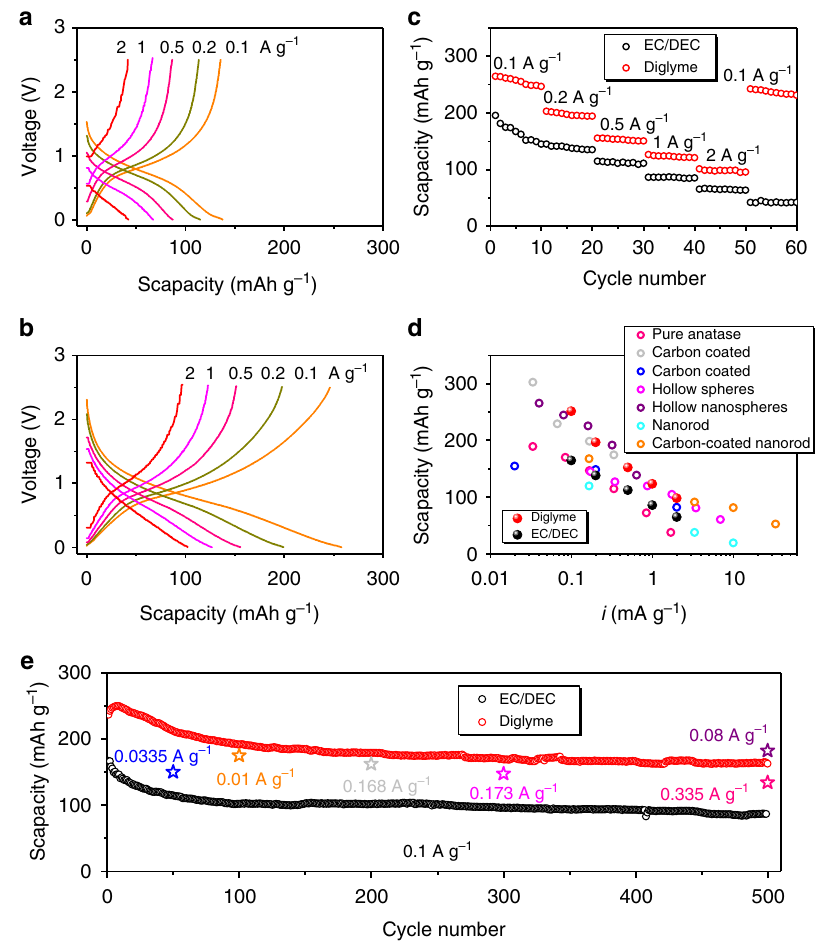
Fig. 1 Battery performance. a Voltage pro fi les of the TiO 2 anode at different rates using the EC/DEC-based electrolyte (scapacity: speci fi c capacity). b Voltage pro fi les of the TiO 2 anode at different rates using the diglyme-based electrolyte. Note that the pro fi les at 0.1 A g − 1 in a and b are for the third cycle while the others are for the fi rst cycle at corresponding rates. c Rate performance. d Performance compared with anatase TiO 2 -based SIB anodes reported in the literature, i.e., pure anatase TiO 2 56 , carbon-coated anatase 57,58 , hollow spheres 23 and hollow nanospheres 59 , anatase nanorods 60 , and coated anatase nanorods 60 . e Cyclic performance at 0.1 A g − 1 , and comparison with cyclic performance reported in the